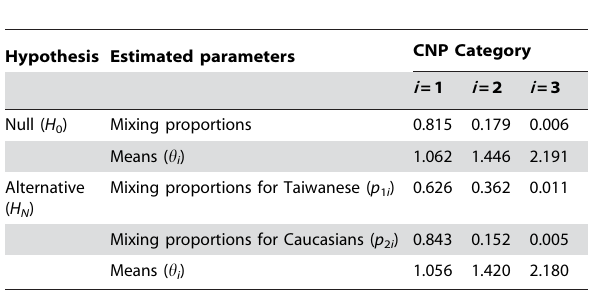
Legend for Table 4. Data are determined for 261 individuals of Caucasian ethnicity and 88 individuals of Taiwanese ethnicity. The estimated variance ( g ) under both the null and alternative hypotheses is 0.03.